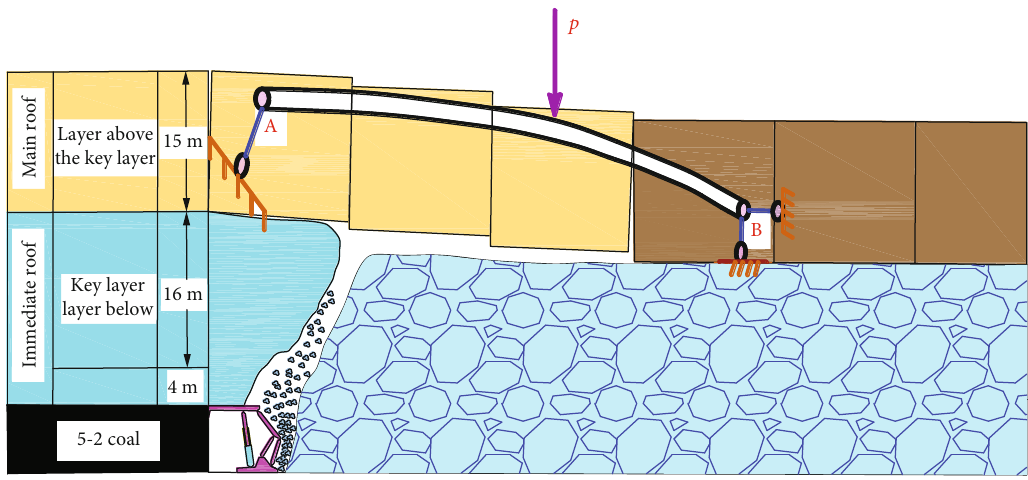
Figure 7: Schematic diagram of the model half arch structure.